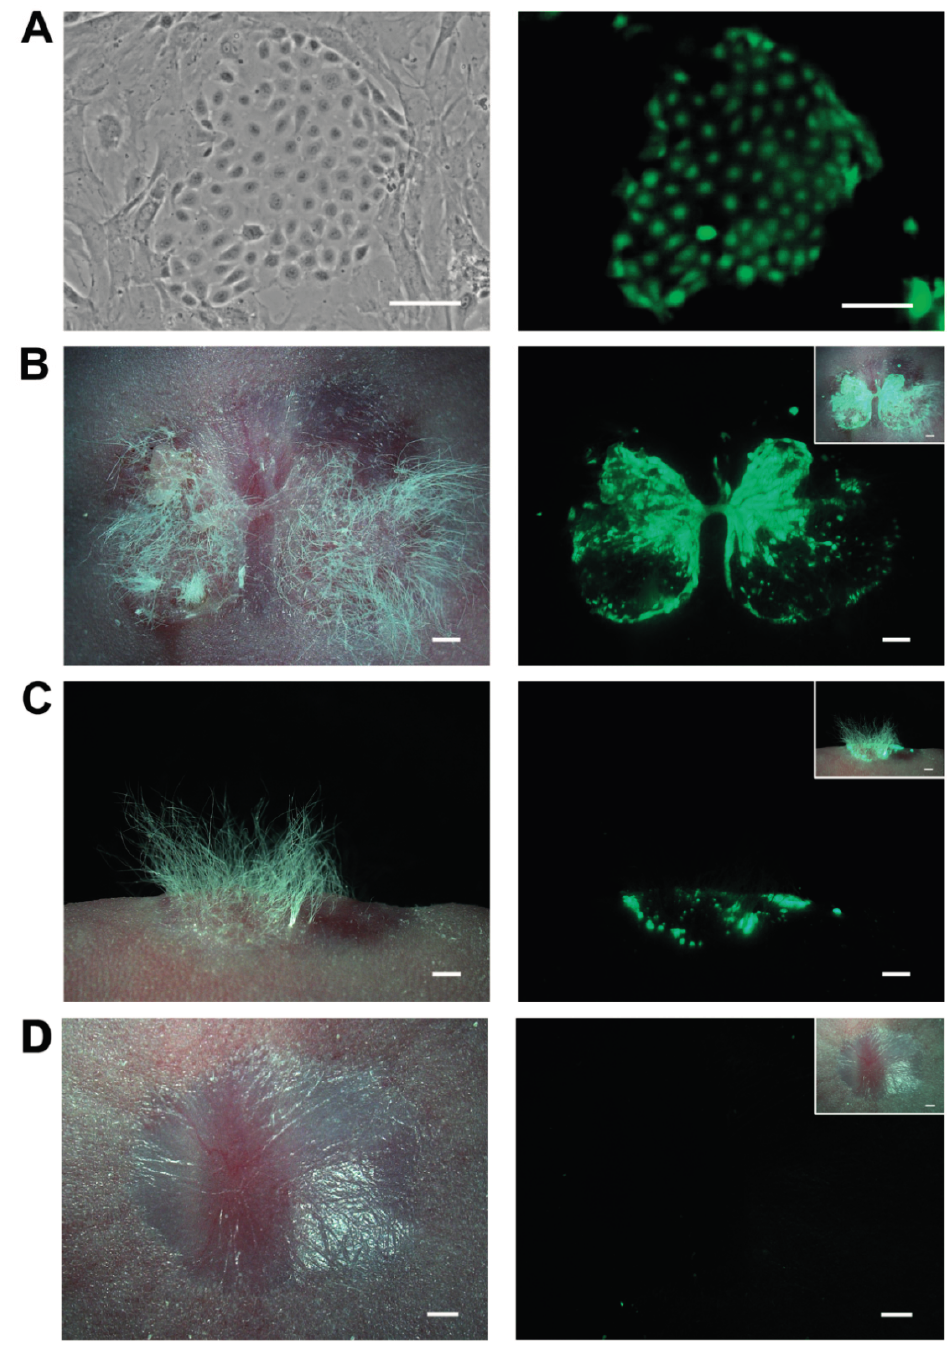
Figure 5. ( A ) A GFP-positive colony of P4 ovine bulge-derived keratinocytes after GFP labeling and FACS. Note the surrounding non-GFP cells are the feeder cells; ( B ) A top view of the graft on the back of the recipient nude mouse four weeks after being grafted with GFP-positive keratinocytes and neonatal CD1 dermal cells; ( C ) A side view of the graft on the back of the recipient nude mouse four weeks after being grafted with GFP-positive keratinocytes and neonatal CD1 dermal cells; ( D ) A top view of the control graft on the back of the nude mouse four weeks after being transplanted with only neonatal CD1 dermal cells. For ( B – D ), the upper-right corner shows the merged view of the bright field and the fluorescence. For ( A ), the scale bar is 100 μ m; for ( B – D ), the scale bar is 1